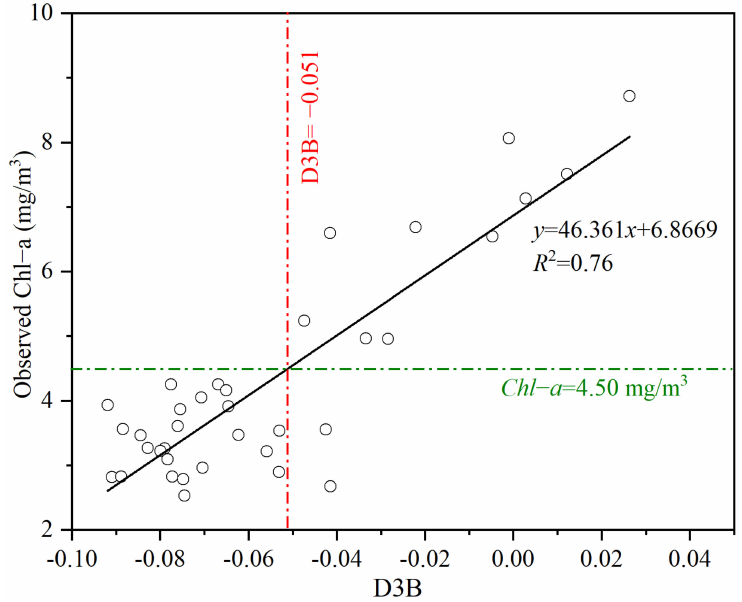
Figure 5. Correlation between the calculated D3B value and measured chl-a